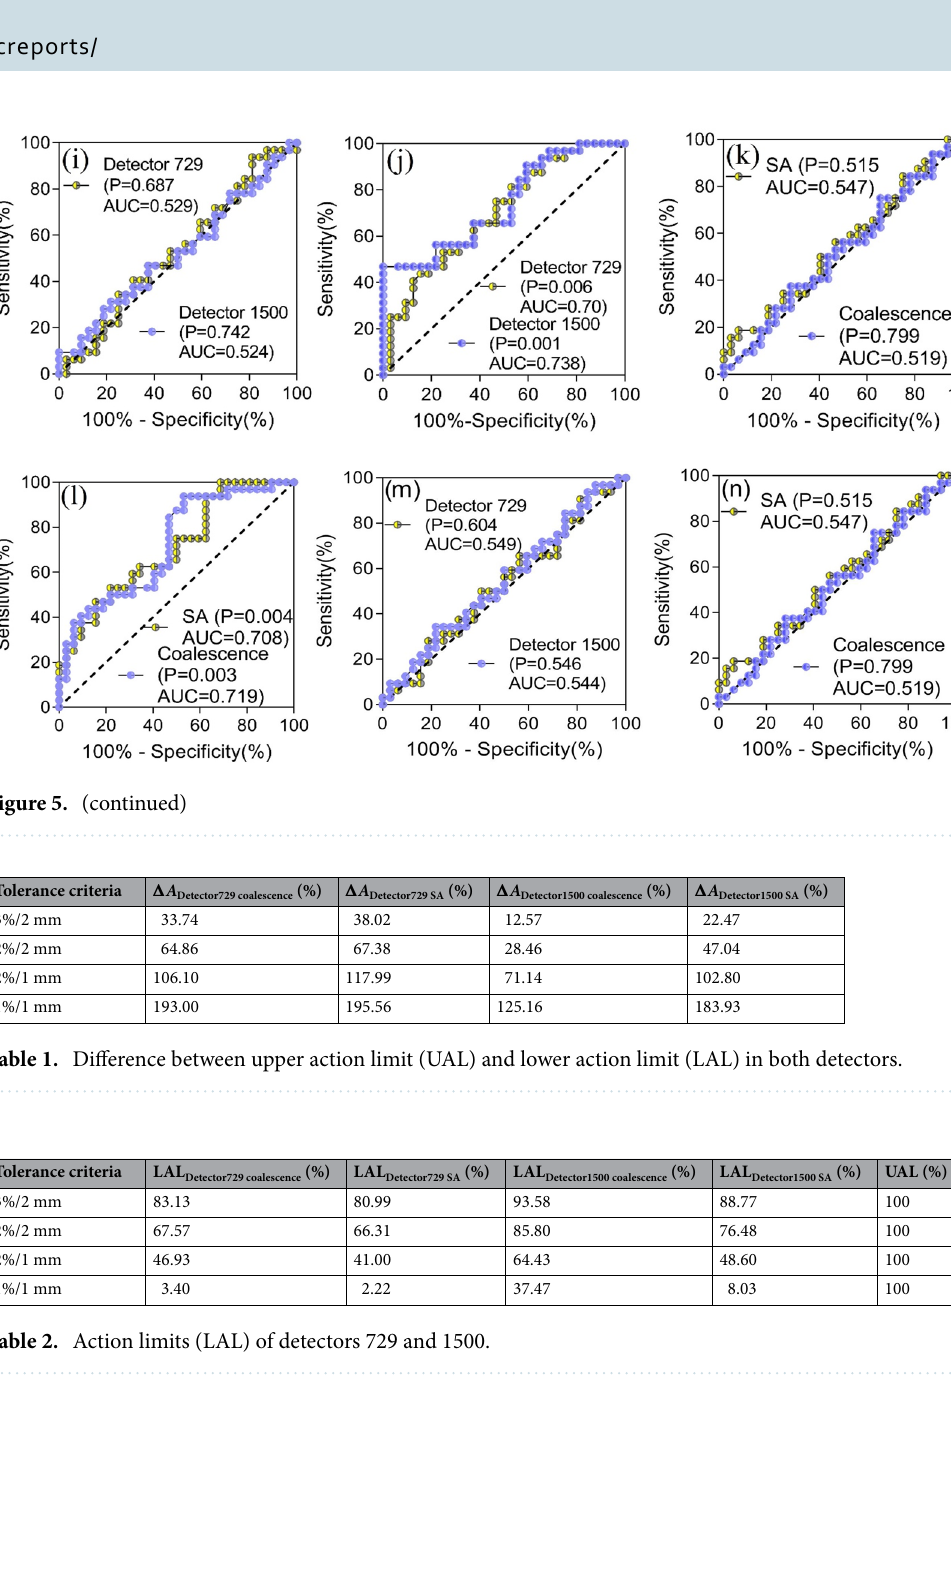
Tolerance criteria